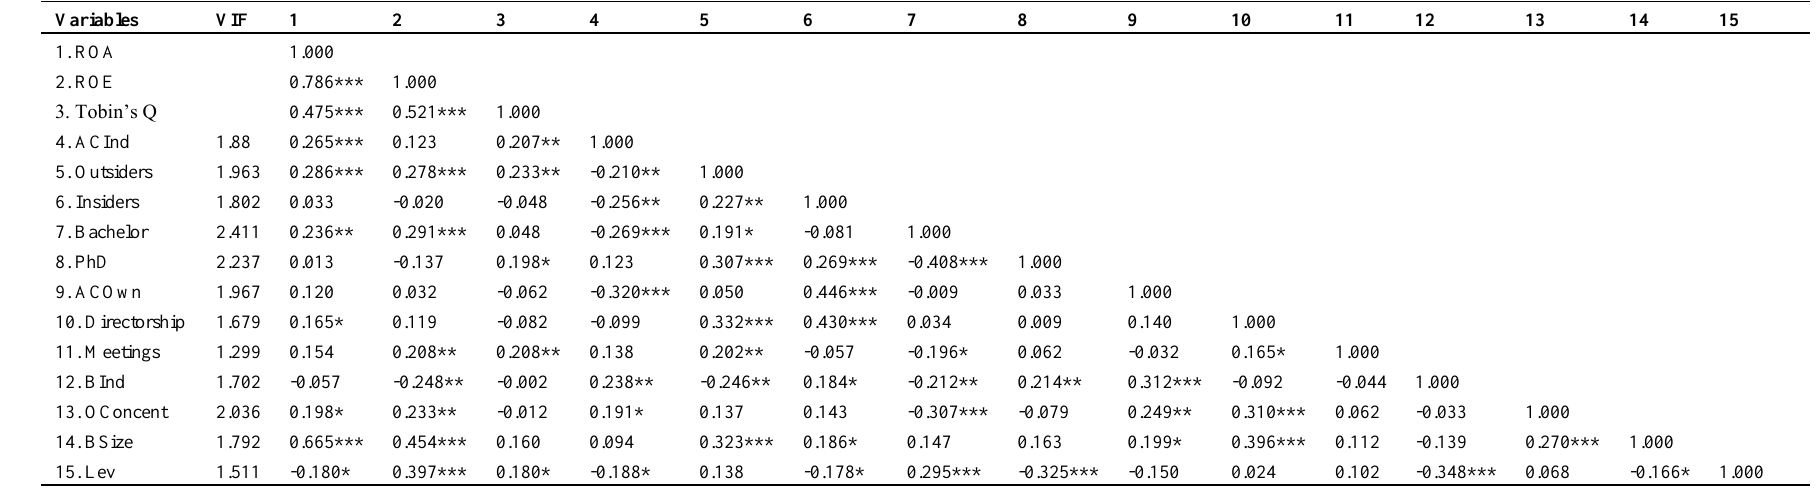
Table 2: Pearson correlation